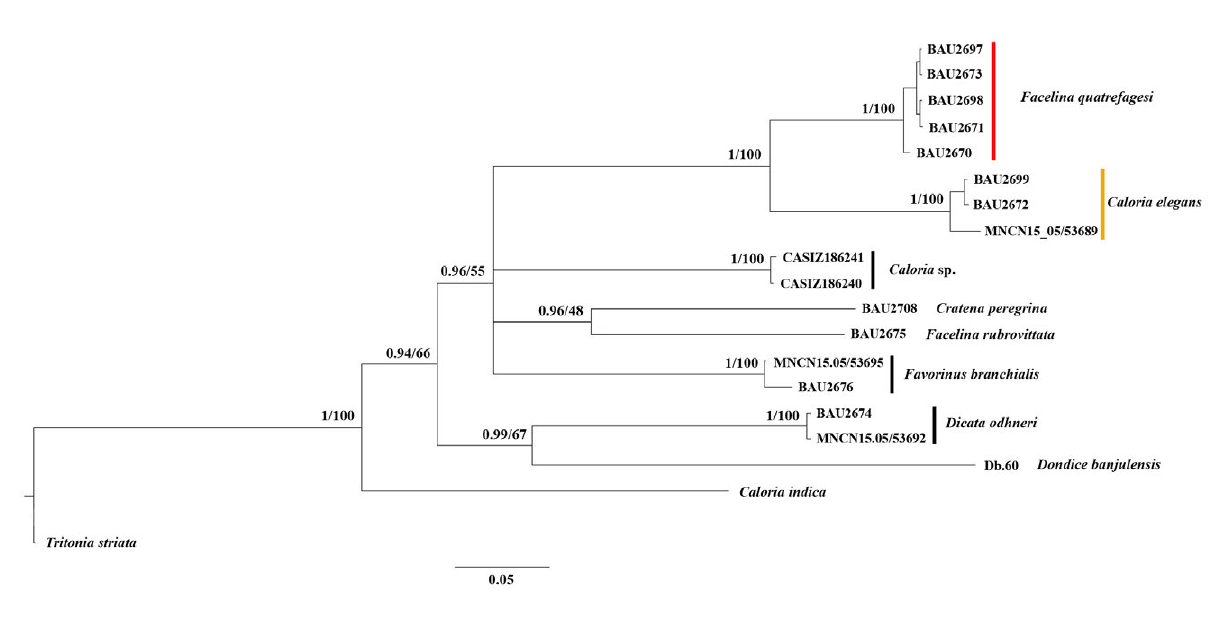
Fig. S1. – Phylogenetic relationships among facelinid species based on the Bayesian analysis of partitioned (16S+COI) mitochondrial dataset. Numbers at nodes are Bayesian posterior probability and ML bootstrap support, respectively.